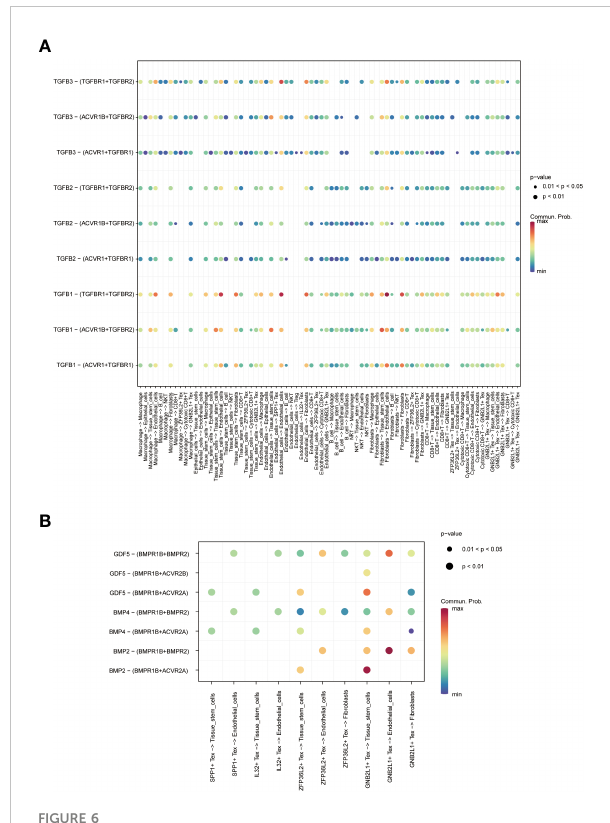
FIGURE 6 Analysis of cell-related pathways. (A) Bubble plots demonstrate the role of TGF- b related pathways across all cells. (B) Bubble plots demonstrate the role of Tex cell-associated